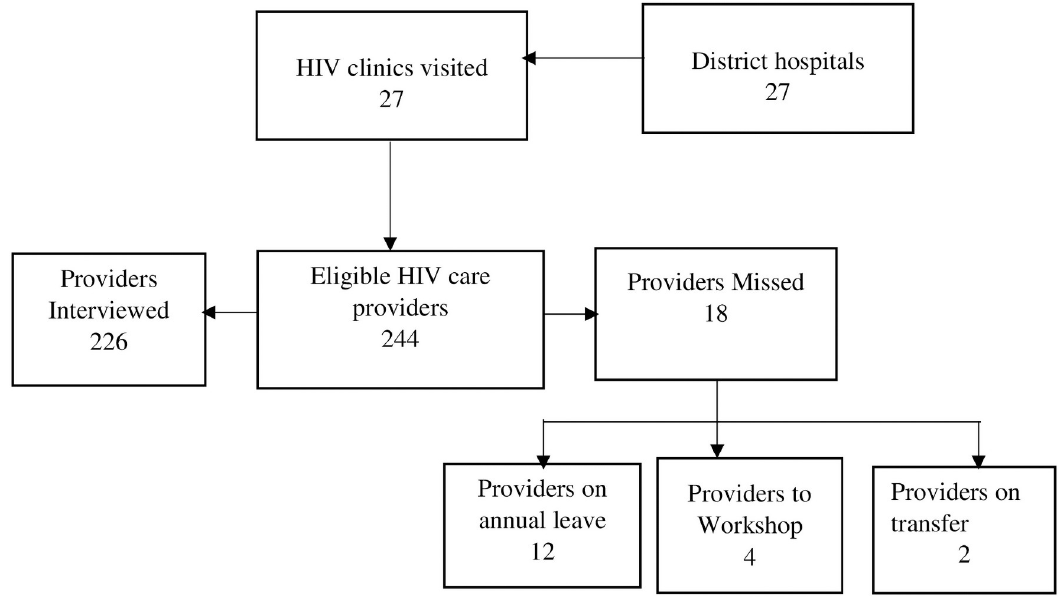
Fig 4. Flowchart of recruitment and study profile of the healthcare providers at the HIV